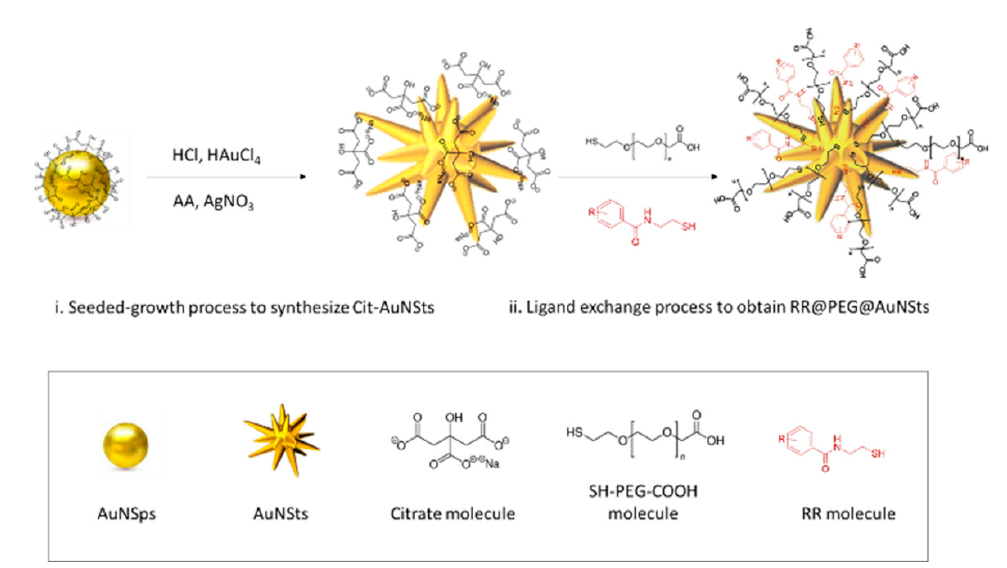
Figure 3. Scheme of the one ‐ pot strategy implemented for SERS nanoprobes engineering.